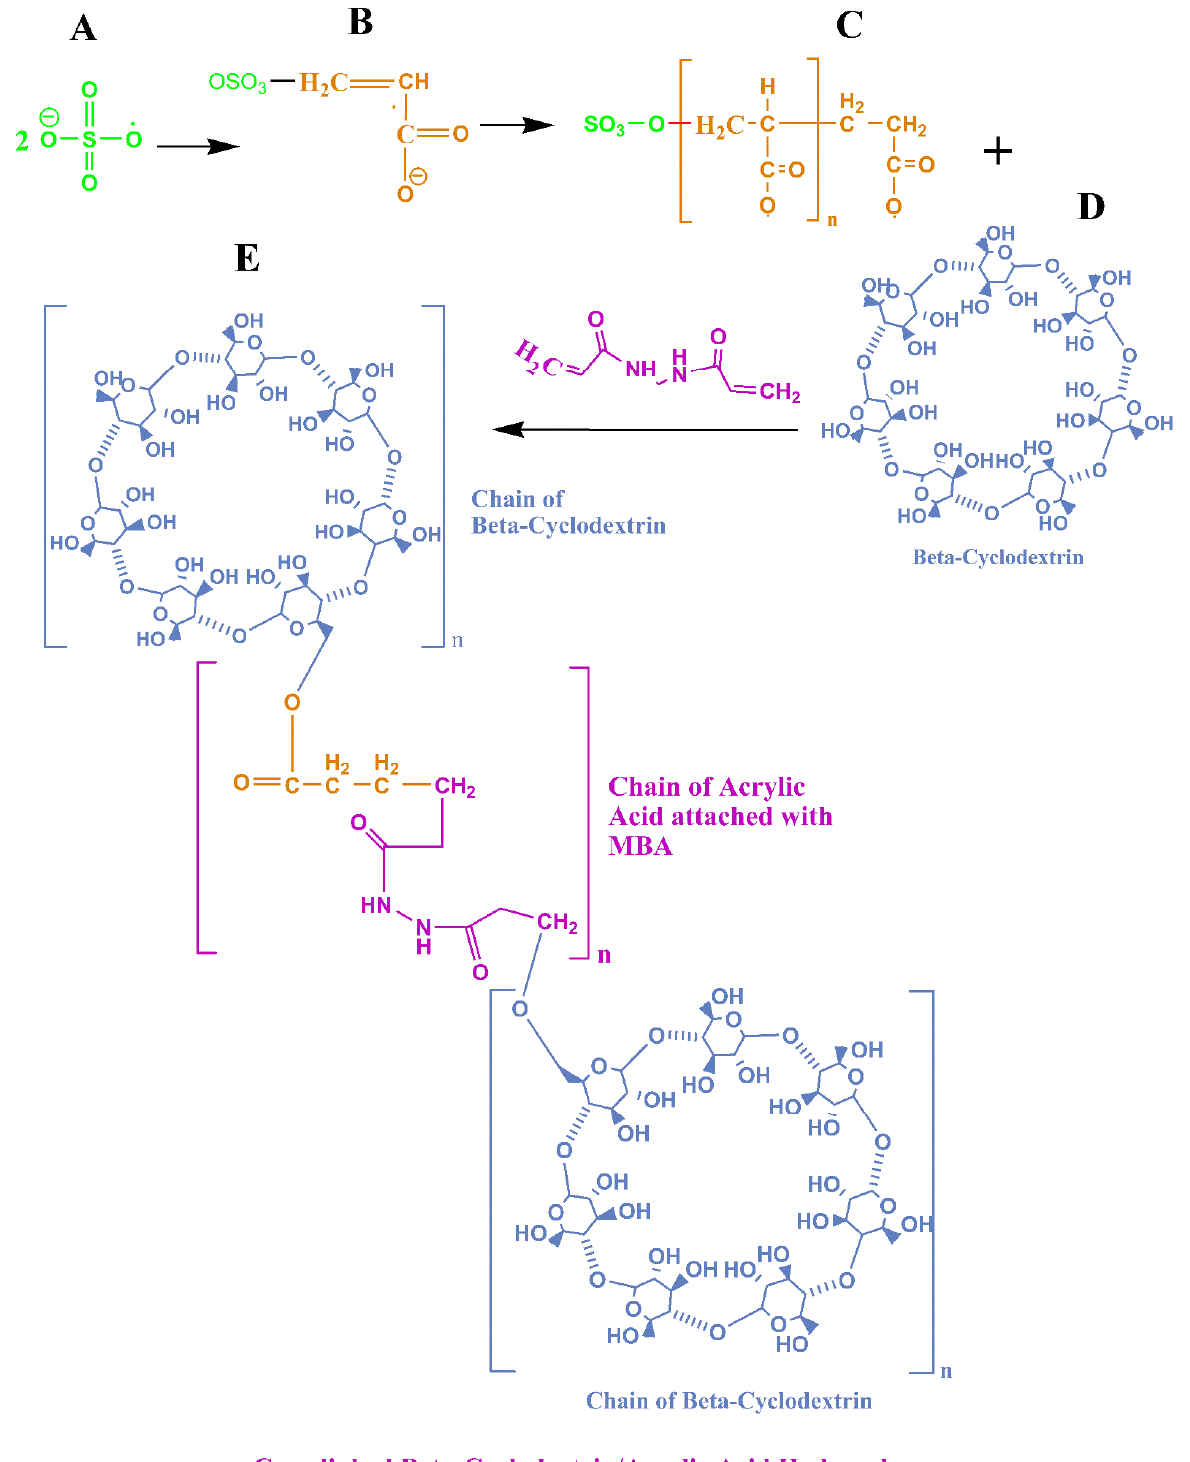
Figure 1. Describing the mechanism of free radical polymerization: how the heating helped the KPS to form free radicals ( A ), followed by its attachment to the acrylic acid to form monomer radicals ( B ). Afterward, a macro-radical was formed by attachment of monomers in the form of a chain ( C ). In the next step, this macro-radical crosslinked with the beta-cyclodextrin, in the presence of MBA ( D ), resulting in the formation of a crosslinked β -CD/AA hydrogel network ( E ).